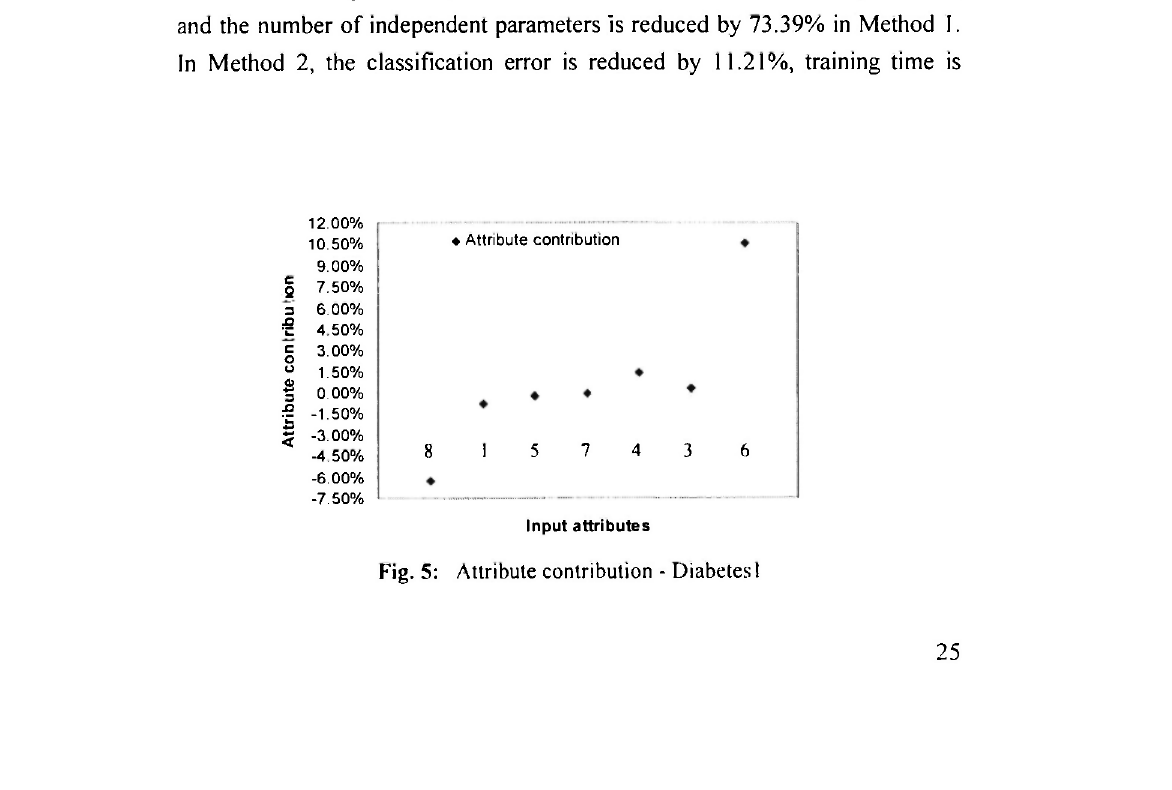
Fig. 5: Attribute contribution -